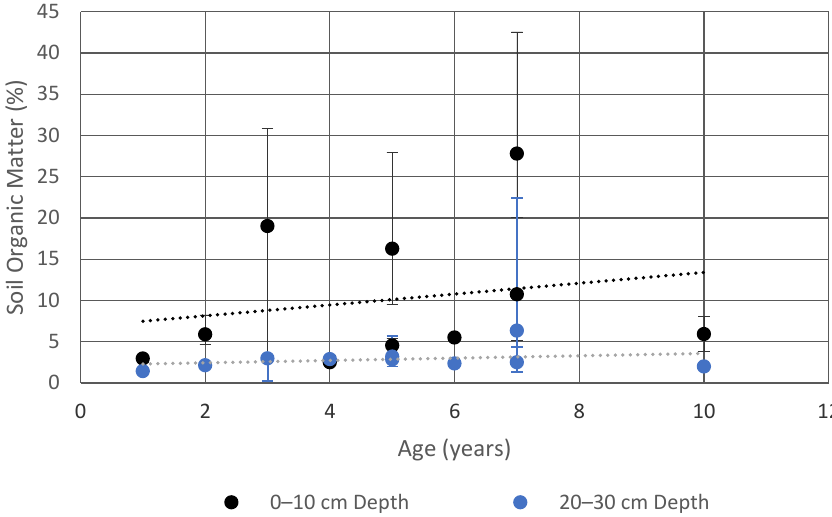
Figure 4. Soil organic matter vs. time for the upper (0–10 cm) and lowest (20–30 cm) soil layers sampled, reported as median ± range.